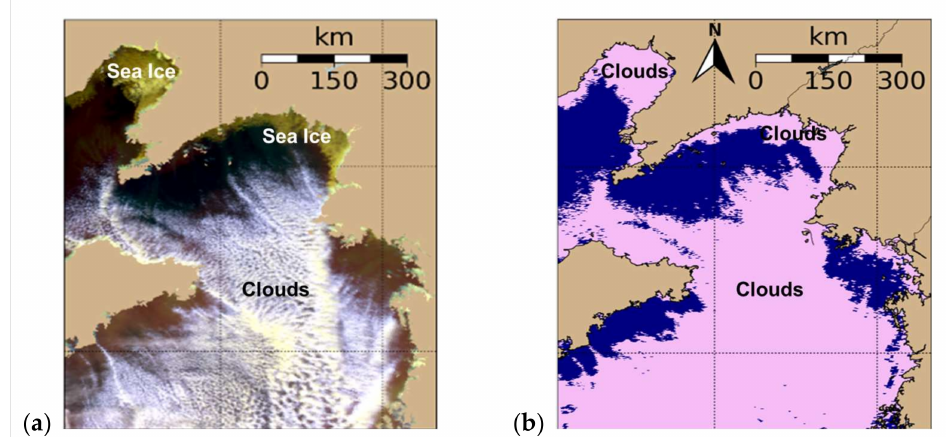
Figure 1. Example of misidentifying sea ice as clouds by MODIS CM. ( a ) MODIS RGB image using 0.56, 0.86, and 1.6 µ m bands [36]; ( b ) MODIS CM (MOD35_L2) on 3 January 2013, 03:15 UTC.